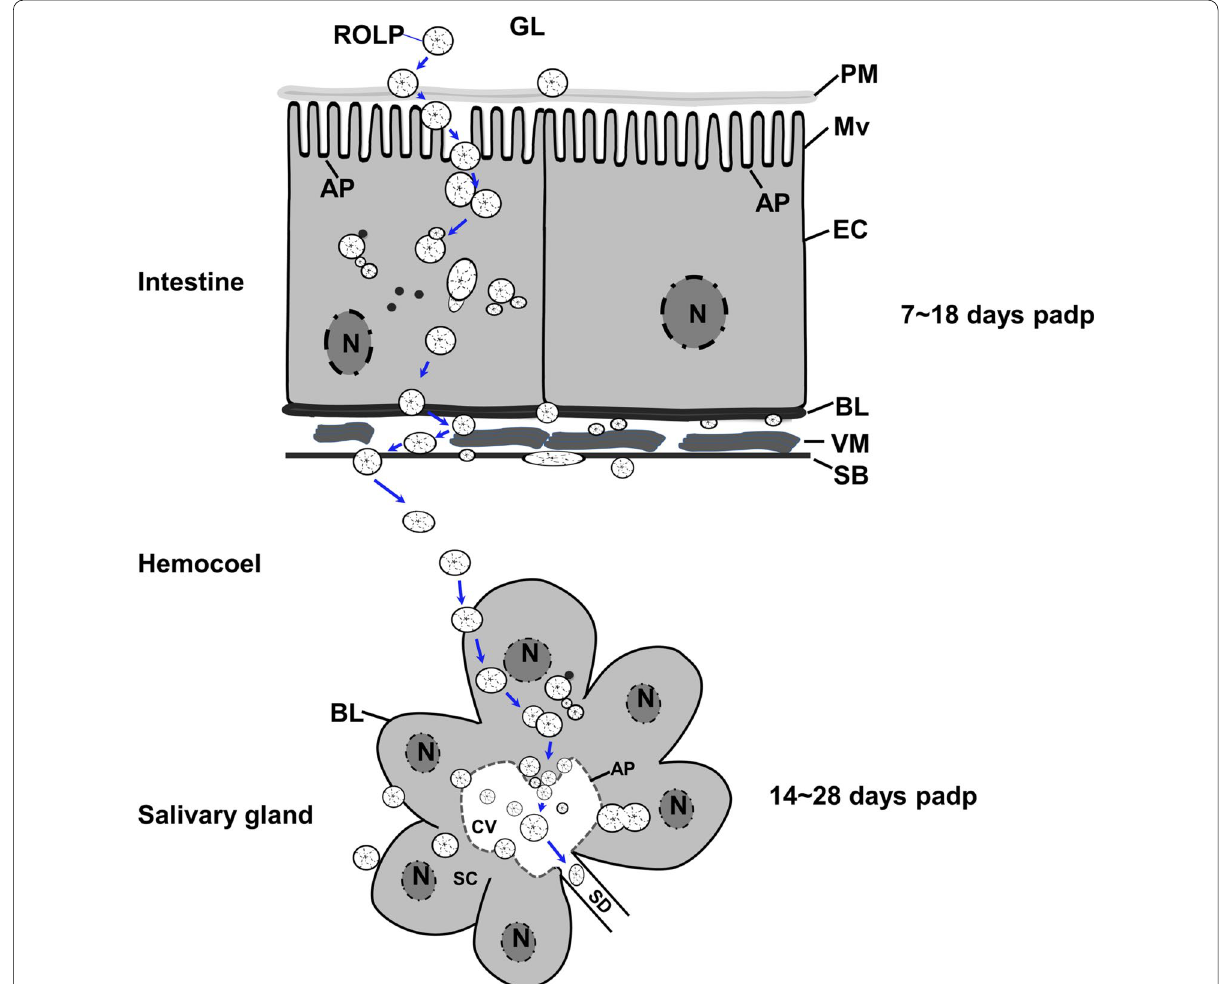
Fig. 7 Proposed model for ROLP entrance, multiplication, and release from insect vectors during transmission. ROLPs acquired from diseased rice plants sequentially traverse the perimicrovillar membrane, microvilli, and apical plasmalemma to enter the intestinal epithelium, where ROLPs produce abundant offspring via budding. The offspring successively traverse the basal lamina and serosal barrier to enter hemolymph. ROLPs in hemolymph then traverse the basal lamina of salivary cells to enter and produce offspring, which finally traverse the apical plasmalemma into saliva storage cavities. Finally, ROLPs are horizontally transmitted to rice phloem together with saliva during insect feeding on rice plants. Blue arrows indicate the process of phytoplasma spread. AP, apical plasmalemma; BL, basal lamina; CV, cavity; EC, epithelial cell; GL, gut lumen; Mv, microvilli; N, nucleus; PM, perimicrovillar membrane; SB, serosal barrier; SC, salivary cytoplasm; SD, salivary duct; VM, visceral